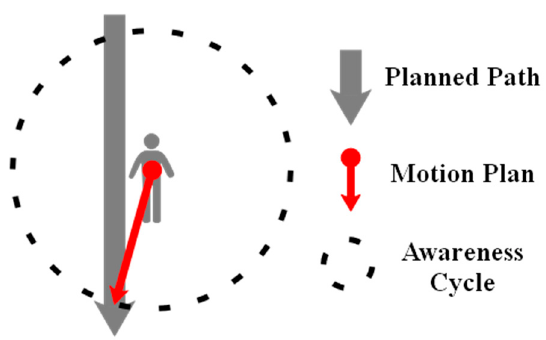
Figure 6. The motion guidance is generated intersecting the planned path and the awareness cycle.